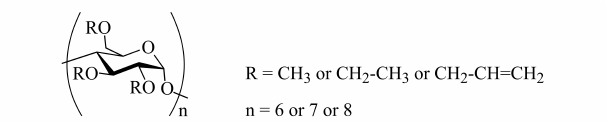
Figure 3. Short hand formula of the applied per -substituted cyclodextrin derivatives.